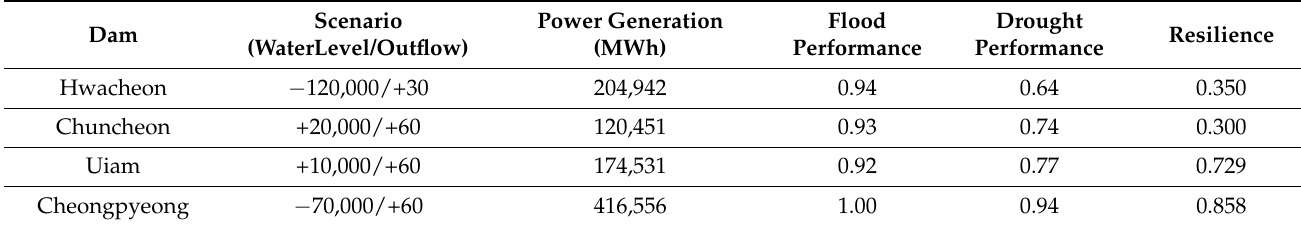
Table 3. Performance Results of Hydropower Dam with